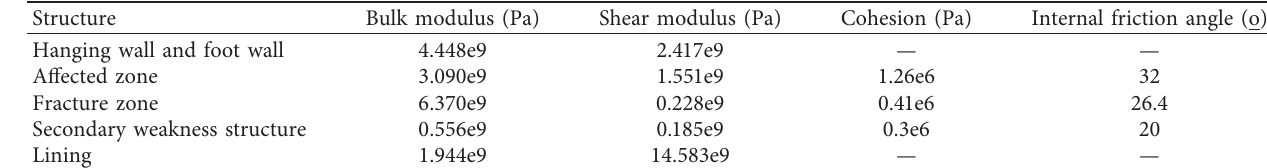
Figure 13: Diagram of numerical simulation model. (a) Schematic diagram of the distributed structure fault. (b) Schematic diagram of multilevel structure fault. (c) Tunnel-distributed fault model. Table 1: The mechanical parameters of each structure in the fault model